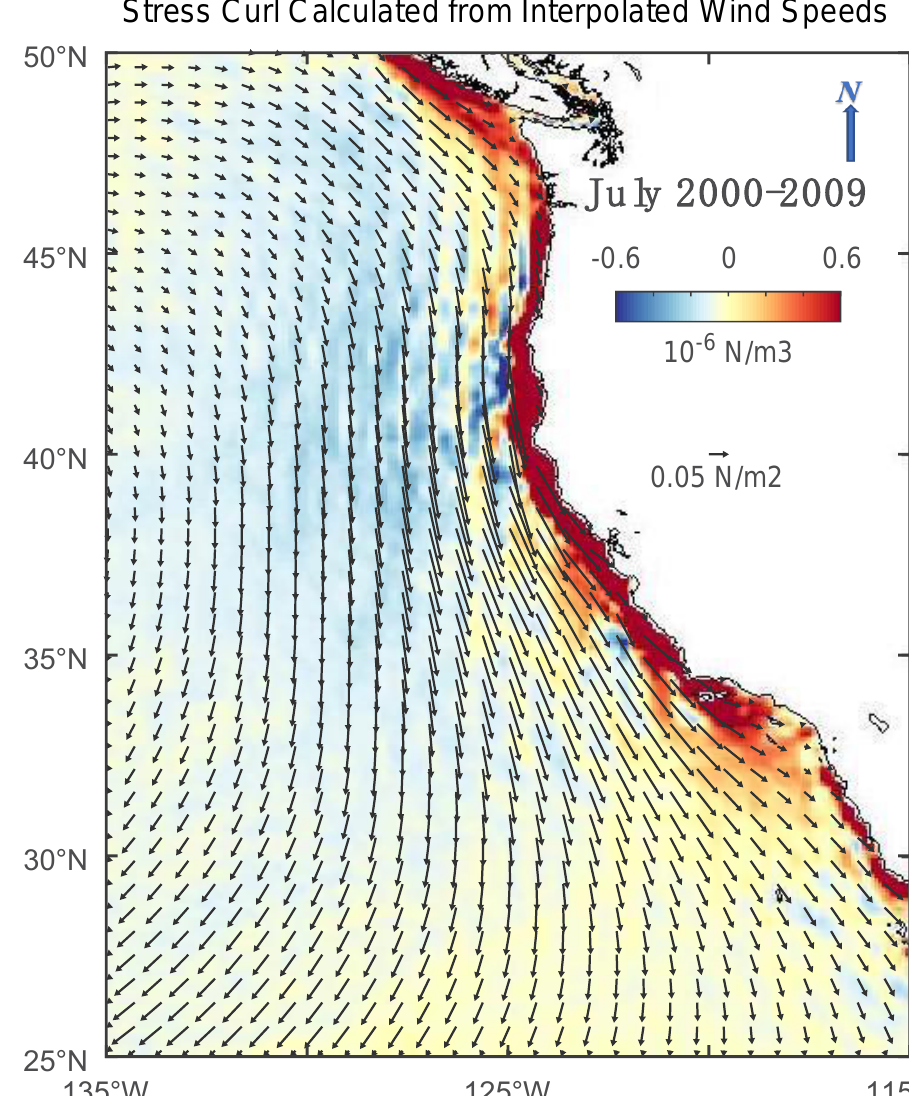
Figure 14. 10-year averages of ERA-5 reanalysis wind stress vectors overlaid on wind stress curl for July as calculated from surface wind speed vectors and other meteorological variables by the ROMS modeling system. Wind speeds are interpolated to a regular rectangular lat-long grid from the native RGG grid before they are provided to the model. (Figure courtesy of Vincent Combes).